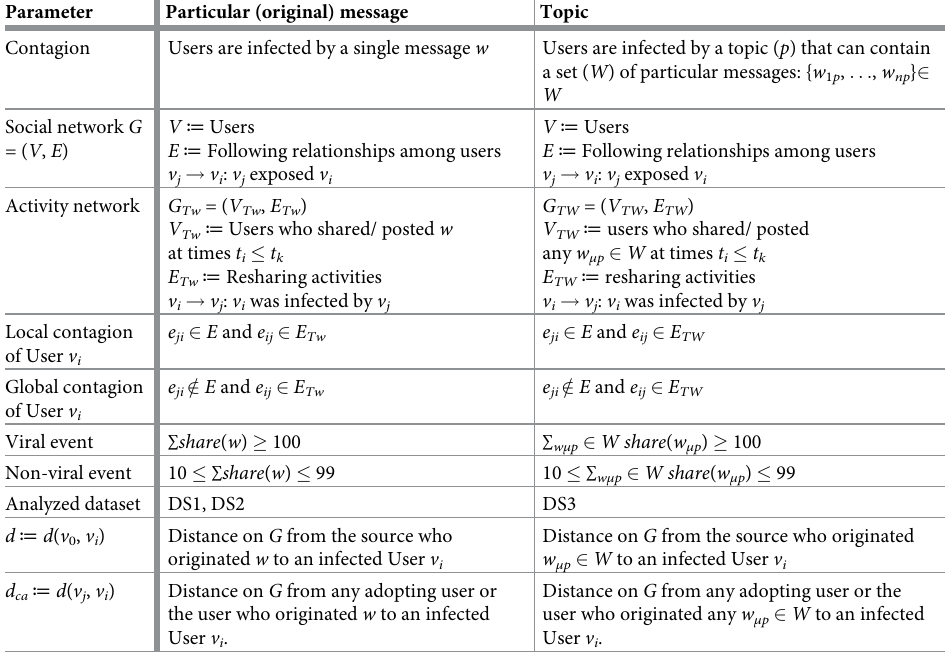
Table 1. A summary of variables